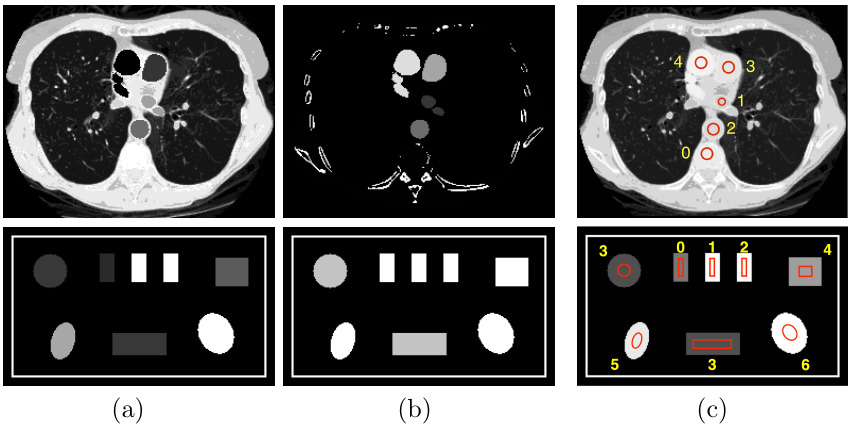
Figure 2. Row 1: ( a ) water and ( b ) iodine basis images and ( c ) VMI at 100 keV of the chest phantom; and row 2: ( a ) photoelectric effect (PE) and ( b ) Compton scattering (KN) basis images and ( c ) VMI at 40 keV of the suitcase phantom. Display windows for the chest phantom are [0, 1.2] for the two basis images and [0, 0.22] cm − 1 for the VMI, while those for the suitcase phantom are [0, 0.22] and [0.1, 0.65] cm − 1 ,